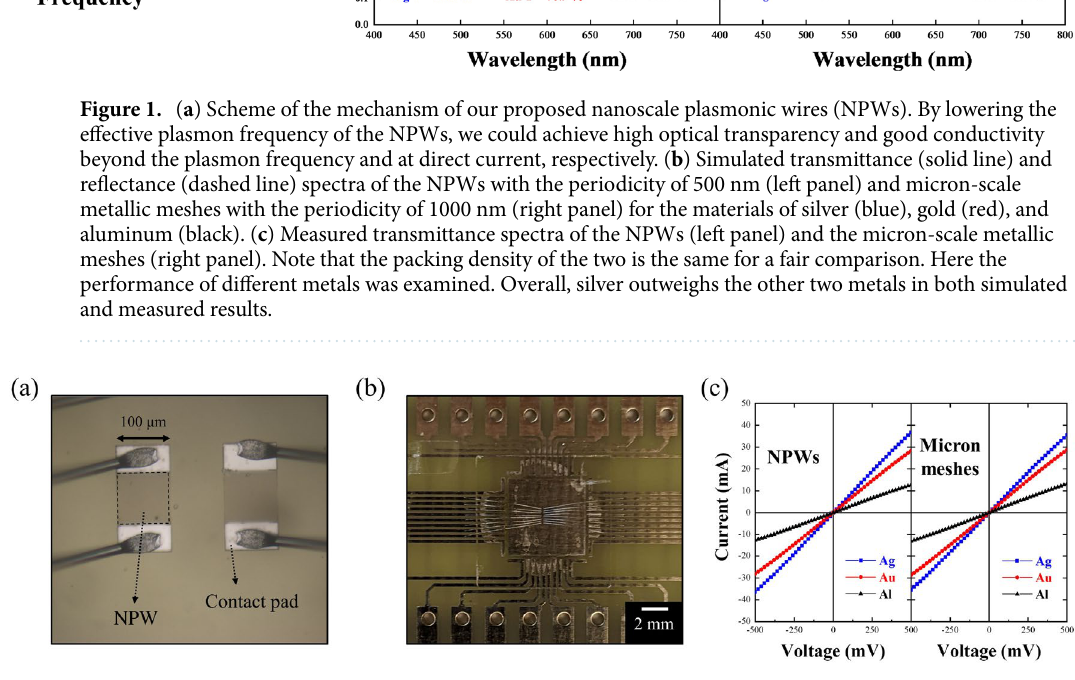
Figure 2. ( a ) Sample wire-bonded to PCB board. ( b ) Optical microscopy image of wire bonding and current– voltage curves for the three different metals of both NPWs and micron-scale